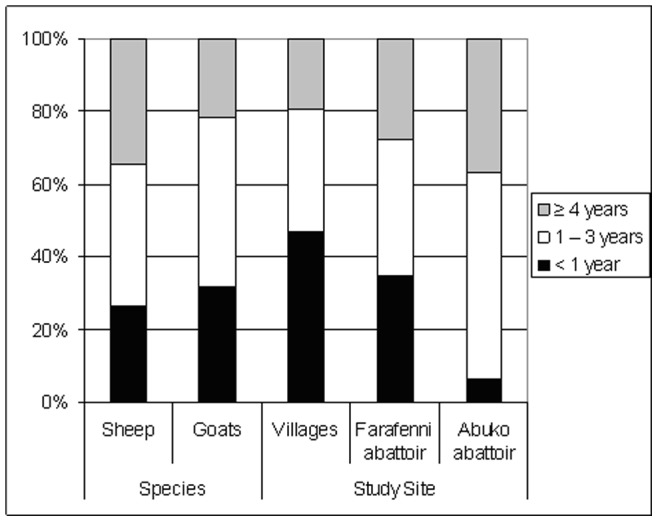
Proportion of sampled animals per age group, related to species and study site.